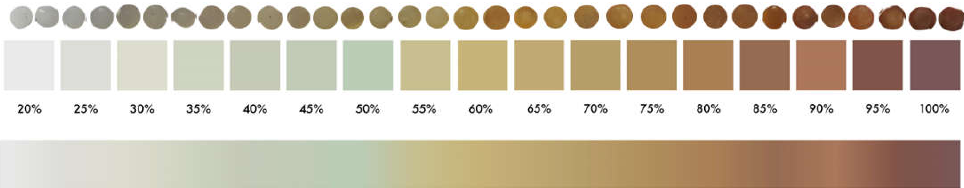
Figure 3. Color palette for Yellowness Index values (%) compared polyethylene pellets classified according to their photo-oxidation degradation process (from a visual point of view).